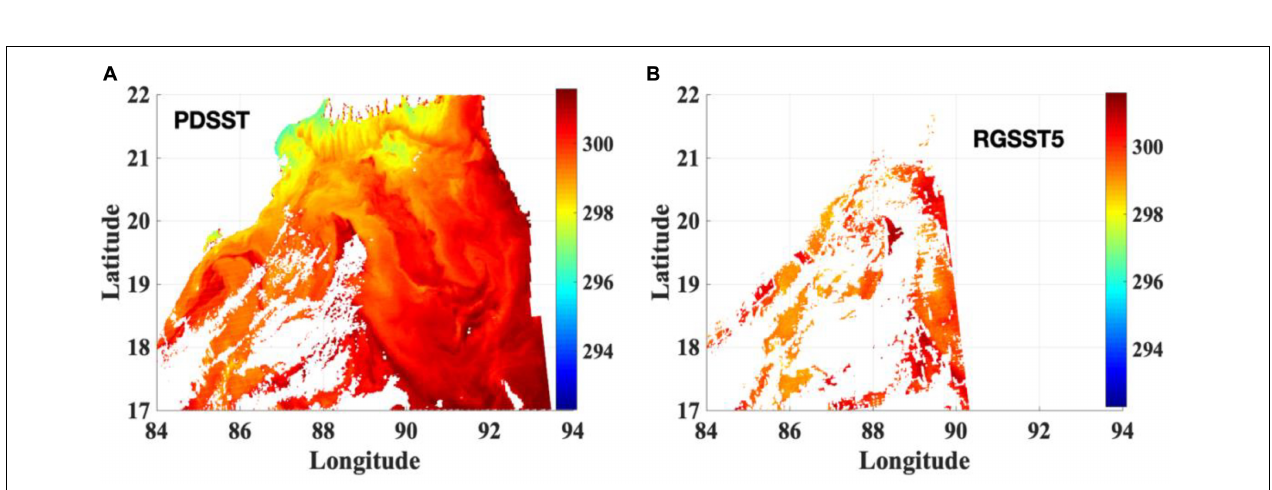
FIGURE 5 | SSTs map for the same area of California coast as in Figure 4 . (A) MWSST from AMSR2, (B) PDSST-MWSST, and (C) RGSST3-MWSST. MD stands for mean differences. The ranges of longitude and latitude from − 180 ◦ to 180 ◦ and from –90 ◦ to 90 ◦ represent West to East and South to North, respectively. Unit of color bar in K.